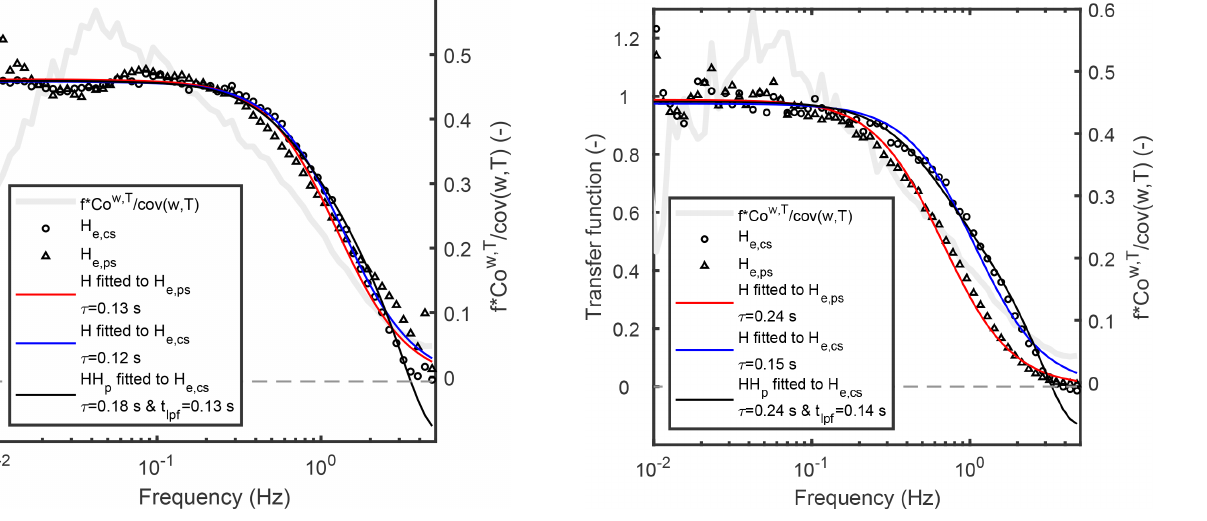
Figure 7. Empirical transfer functions estimated for CO 2 from ensemble-averaged cospectra ( H e , cs ; Eq. 12) and power spectra ( H e , ps ; Eq. 13) and three fits to the empirical transfer functions. Also the corresponding frequency-weighted normalised average cospectrum related to heat flux is shown (grey line) in order to illus- trate the frequency range with the highest contribution to the scalar fluxes. Data from Siikaneva were used.